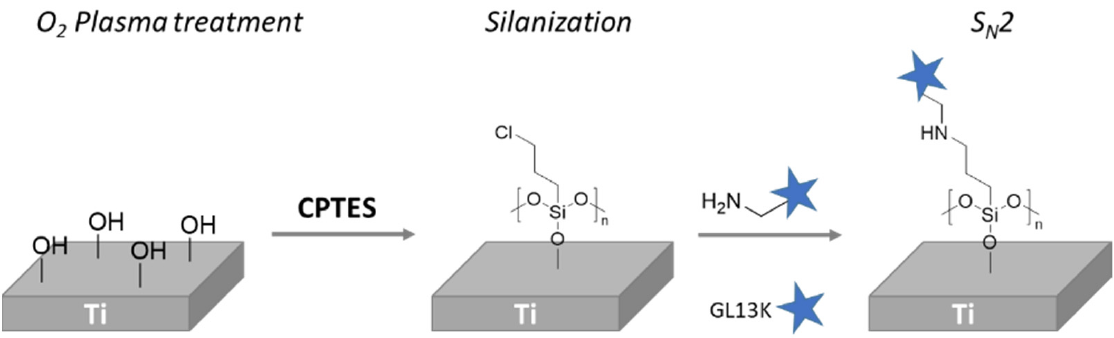
Figure 6. Schematic representation of GLK13K protein immobilization onto Ti surface.